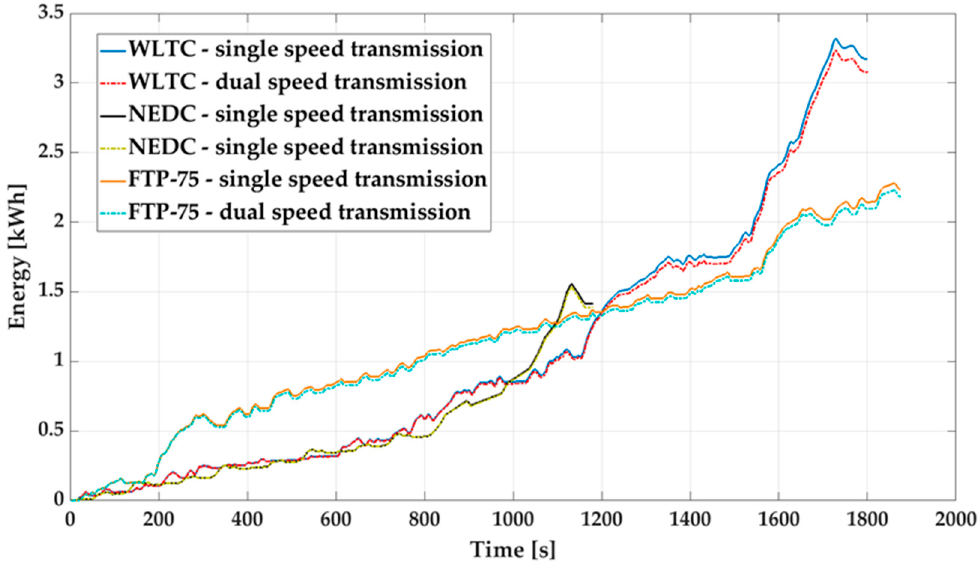
Figure 13. Cumulative electric energy vs. time for WLTC, NEDC and FTP-75.